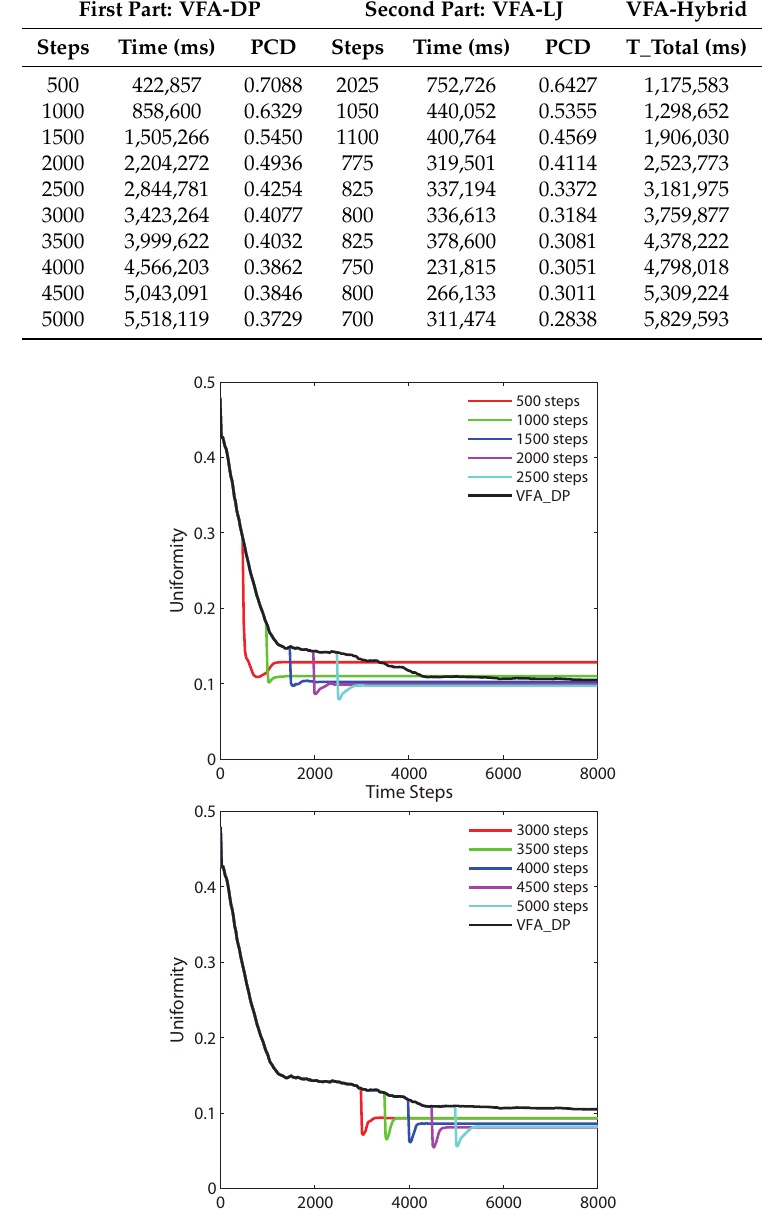
Figure 6. Typical profiles of system uniformity, as a function of the time step, calculated for the specified switch time from VFA-DP to